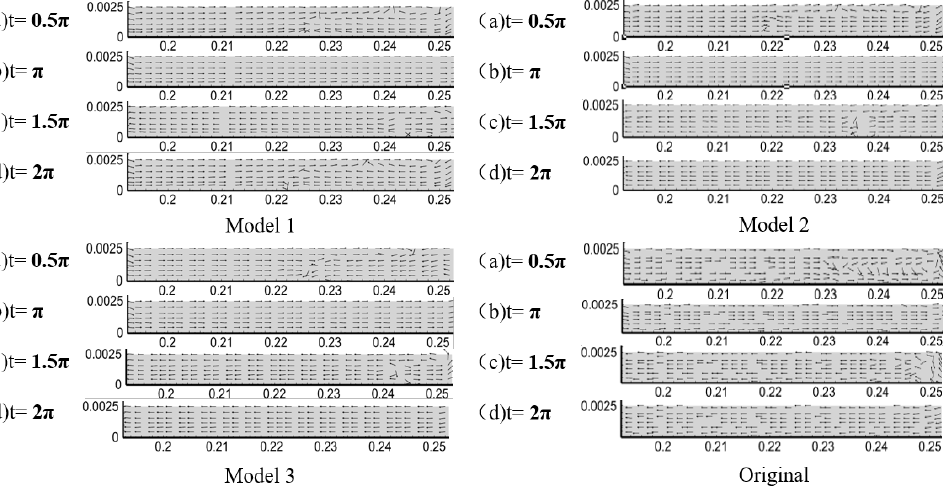
Figure 8. Pulse tube velocity vector diagram.